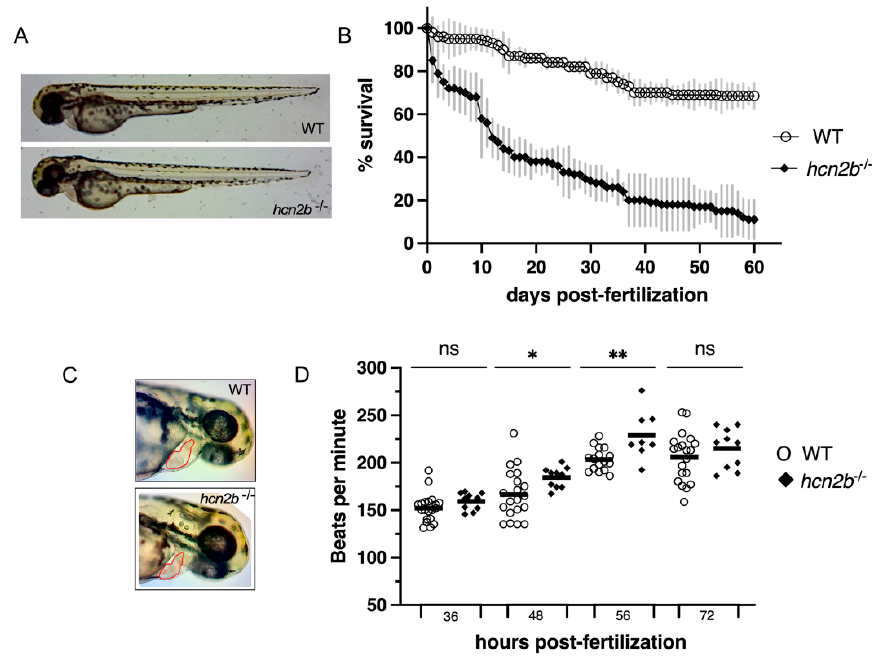
Figure 2. Characterization of the hcn2b − / − mutant. ( A ) Compared morphology between WT and hcn2b − / − zebrafish mutant at 48 h post-fertilization (hpf): there are no differences in length and pigmentation. ( B ) Homozygous hcn2b mutants showed a higher mortality rate than controls (4–16% vs. 60–80%). ( C ) No evident defects were detected during early heart development. Both heart morphology and volume were similar in WT and hcn2b − / − ( D ). Heart rate showed statistically significant differences between WT and hcn2b − / − larvae at 48- and 56-h post-fertilization. Asterisk indicate statistical significance compared to the control, p < 0.05 (*); p < 0.005 (**).